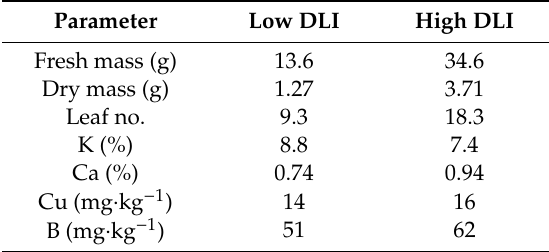
Table 4. Fresh and dry mass, leaf number, and K, Ca, Cu, and B concentrations of cilantro ( Coriandrum sativum ‘Santo’) 4 weeks after transplanting into nutrient-film technique hydroponic systems in